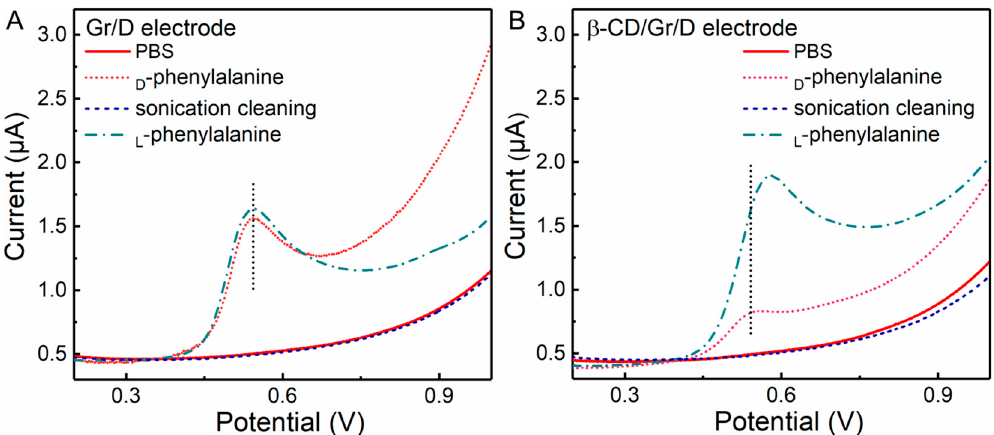
Figure 3. Linear sweep voltammetry (LSV) responses of ( A ) G/D and ( B ) β -CD/G/D in the absence and presence of 0.1 mM L - and D -phenylalanine in 0.1 M PBS (pH 7.0). Amplitude: 50 mV; Pulse width: 0.05 s; Pulse period: 0.5 s.